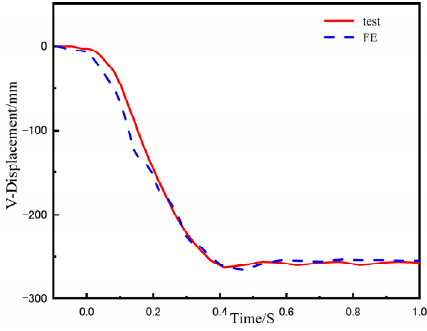
Figure 7. LJ2 displacement time history.